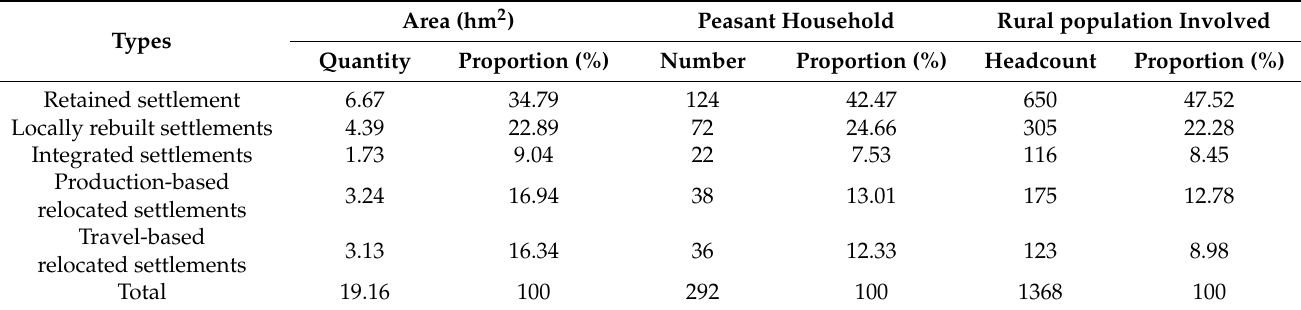
Table 6. Spatial differentiation of rural settlements according to different relocation